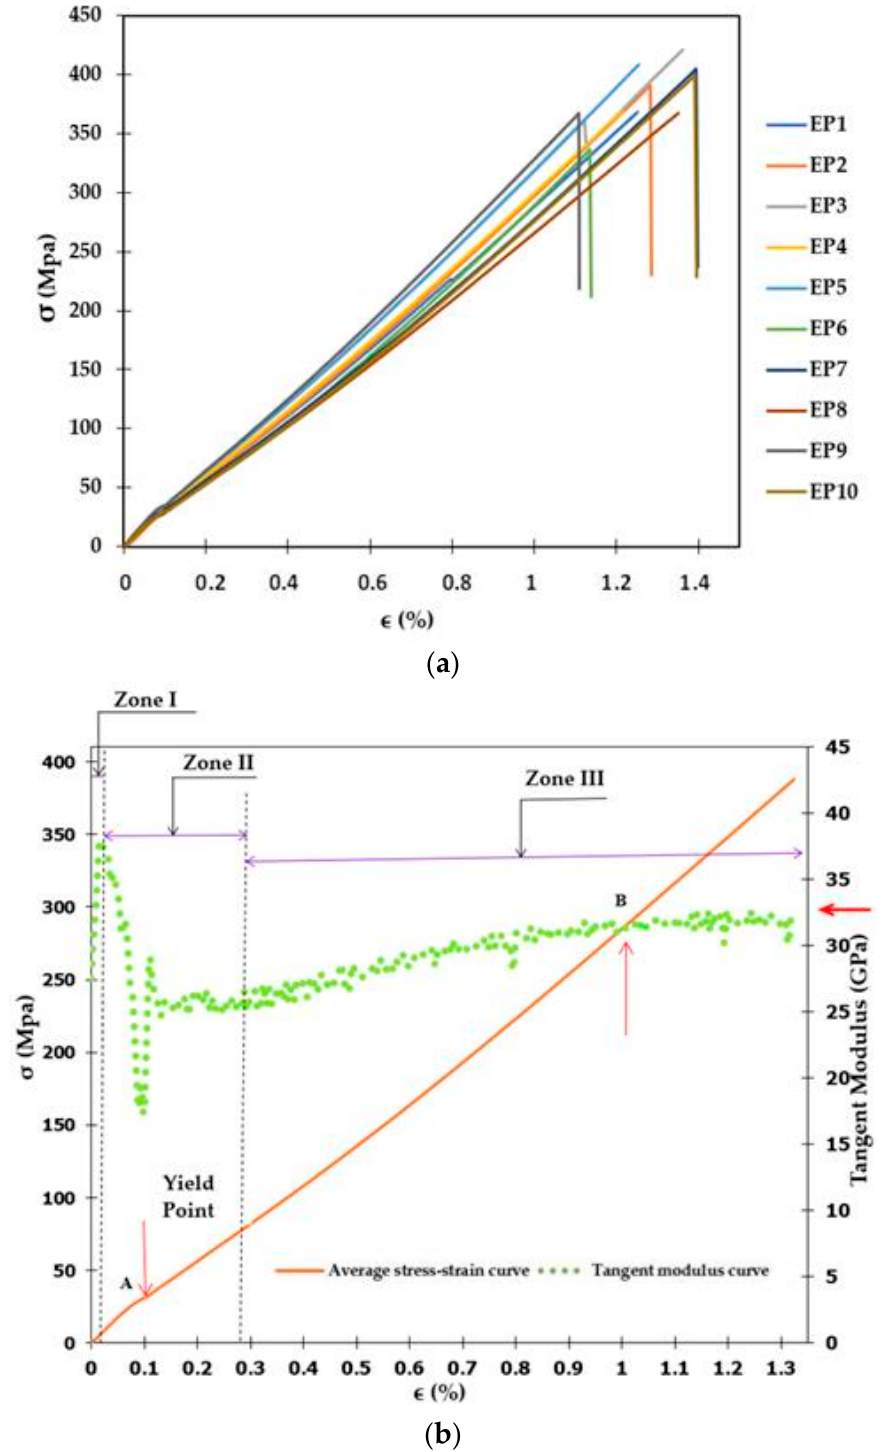
Figure 5. Tensile properties of IFBT samples from hackled CL fibers bundles: ( a ) Tensile stress–strain curves of the 10 specimens; ( b ) evolution of the average tangent modulus.